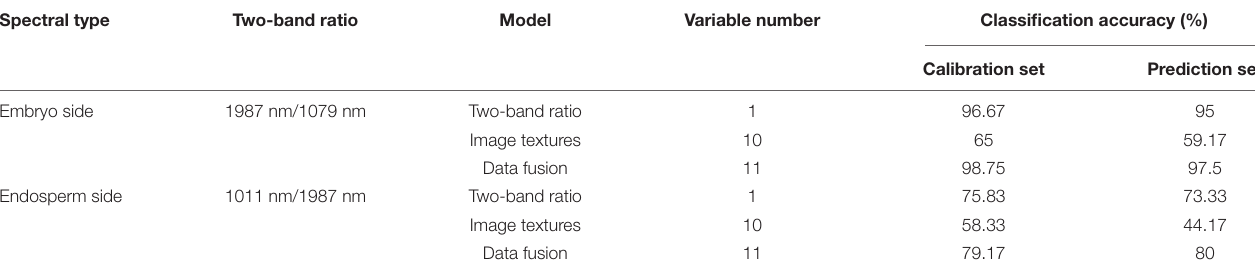
FIGURE 5 | Comparison of the images obtained by using the hyperspectral image. TABLE 5 | The classification results based on various feature variables using SVM